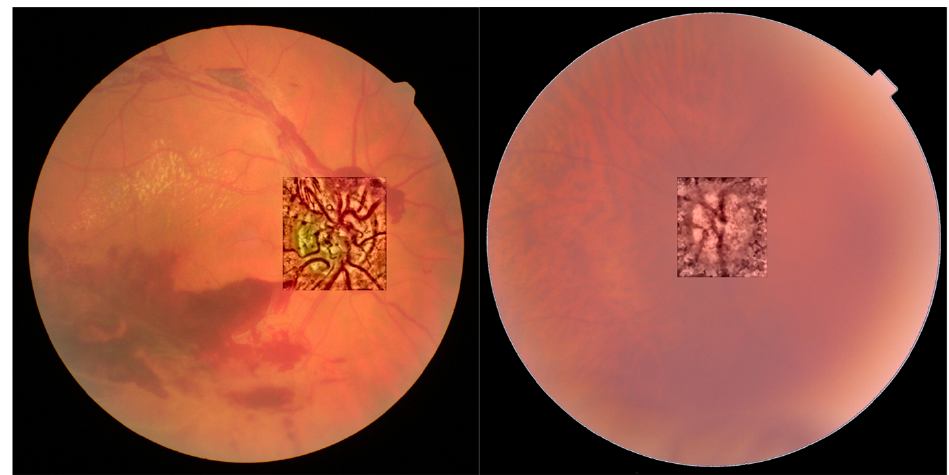
Figure 10. Optical disc region for non-cataract with bleeding ( left ) and severe cataract ( right ).